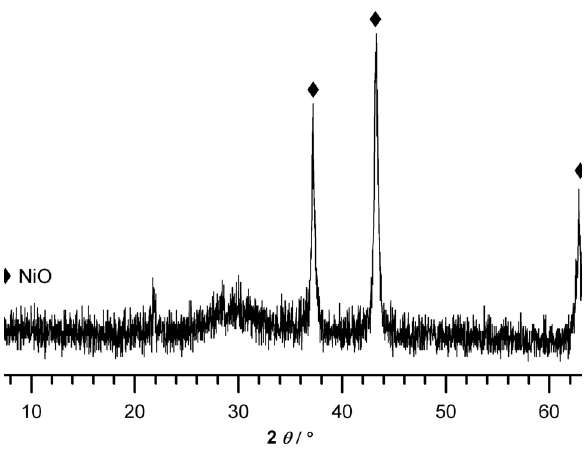
Figure 7. XRD pattern of the product after thermal treatment of [ Ni(dtsq) ] in air. (HexPh P) 3 2 2